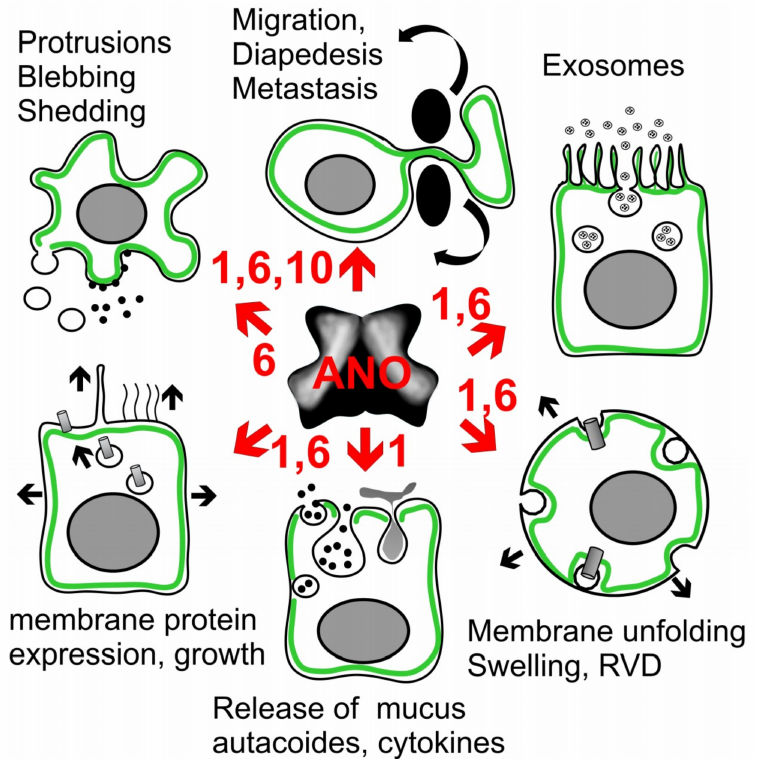
Figure 5. Potential action of anoctamins on exocytosis, growth and microvesicular signaling. ANO1 and ANO6 determine the extent of membrane protrusions and membrane blebbing in macrophages and other cell types, and support cell migration, diapedesis and cancer metastasis. Exosome release and paracrine signaling by epithelial cells is probably anoctamin-dependent. Support of membrane unfolding, cell swelling and subsequent activation of VRAC could be a general property of anoctamins. Mucus secretion and release of inflammatory mediators such as autacoids and cytokines was shown to be ANO1-dependent. Exocytosis leads to enhanced expression of membrane proteins, cell growth, and extensions such as motile cilia and the primary cilium, as proposed for ANO1. For further details and references, see main